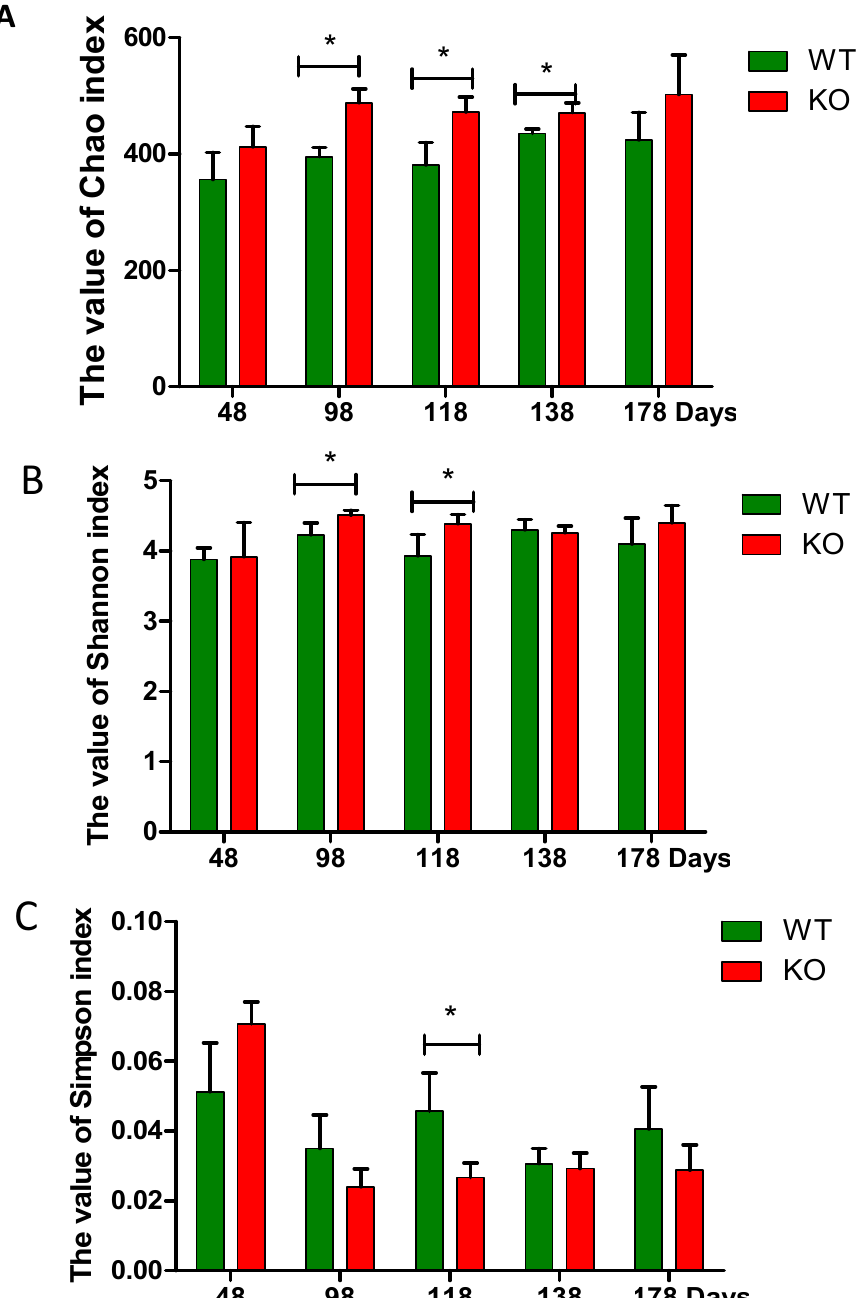
Figure 2. Bacterial diversity analyzed by high-throughput sequencing. ( A ) Chao index; ( B ) Shannon index; ( C ) Simpson index. * indicated significant differences ( p < 0.05) between Muc2 − / − and Muc2 +/+ mice. The results are presented as the mean ± SEM; n = 3 for each group. WT, Muc2 +/+ mice; KO, Muc2 − / − mice.